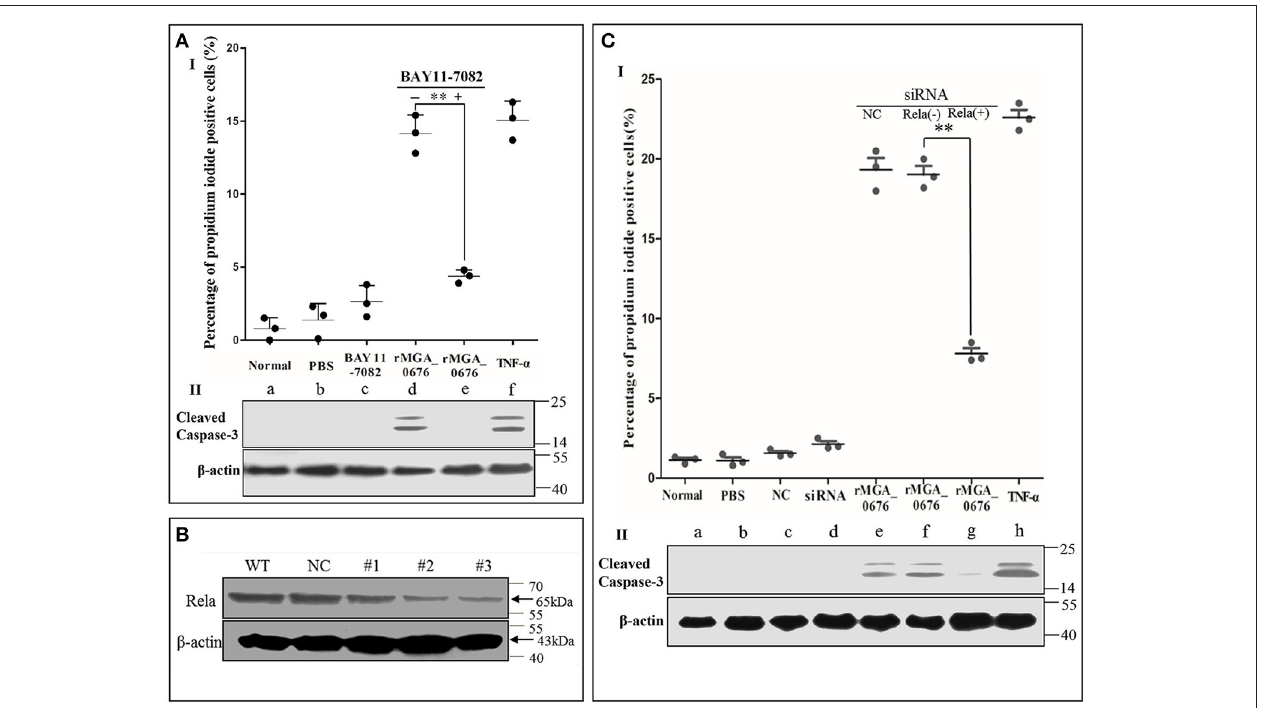
FIGURE 8 | rMGA_0676 activates NF- κ B inducing apoptosis in DF-1 cells. (AI) rMGA_0676-induced apoptosis in DF-1 cells was arrested by an NF- κ B inhibitor. The cells were seeded on 12-well plates and cultured overnight. Apoptosis was assessed by the percentage of propidium iodide-positive cells following the treatment. a: normal cells; b: cells were treated with PBS; c: cells were treated with BAY 11-7082; d: cells were treated with rMGA_0676; e: cells were pretreated with BAY 11-7082 for 1h at 37 ◦ C and then treated with rMGA_0676; f: cells were treated with TNF- α . The data were analyzed using SPSS software, and the graph was made